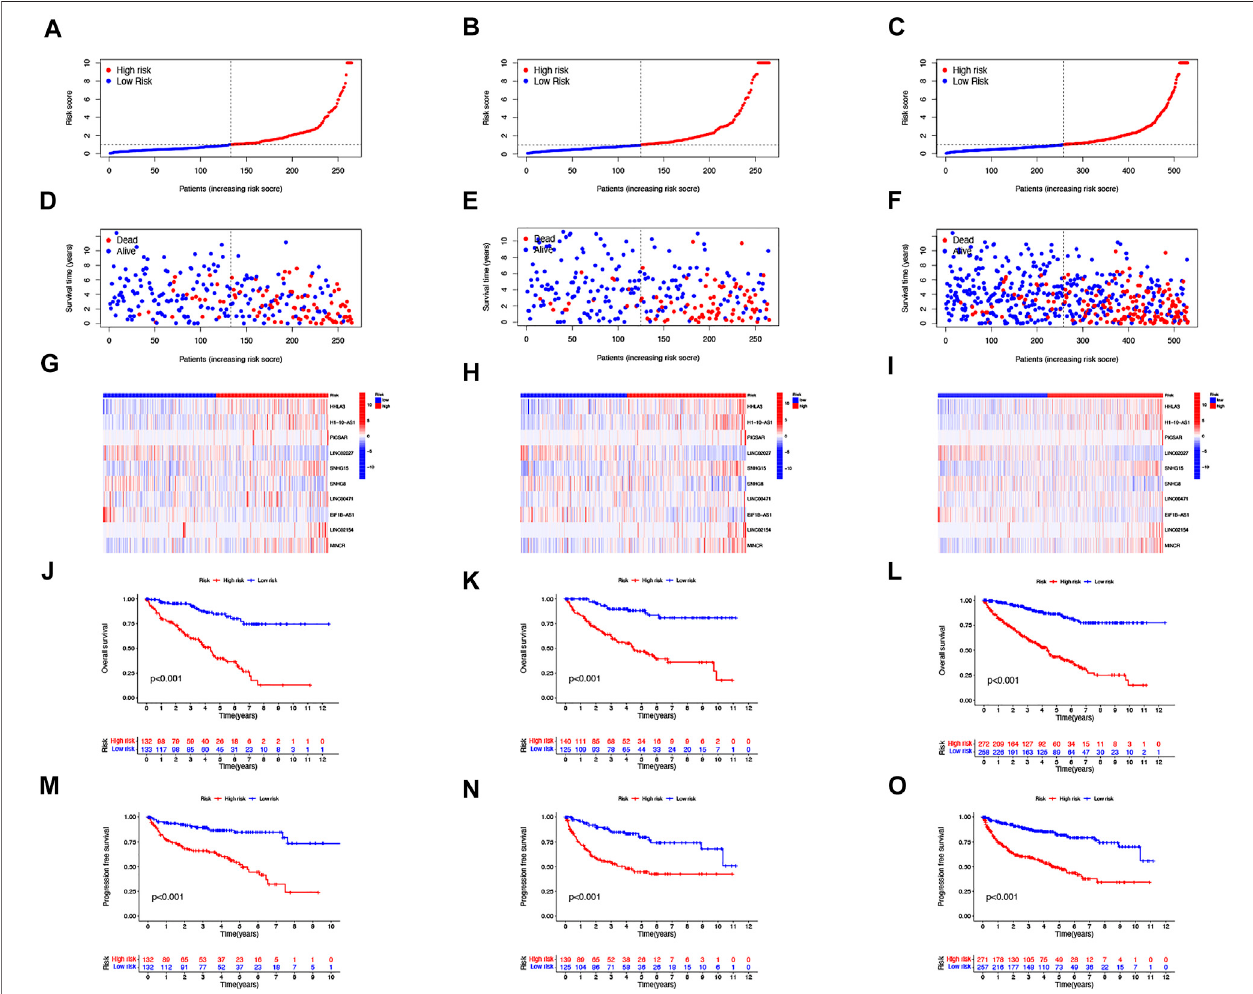
FIGURE2| Prognosisoftheriskmodelindifferentgroups.Thedistributionofoverallsurvivalriskscores (A – C) ,survivaltimeandsurvivalstatus (D – F) ,heatmapsof 10 lncRNA expressions (G – I) , Kaplan – Meier survival curves of overall survival of ccRCC patients (J – L) , and Kaplan – Meier survival curves of progression-free survival of ccRCC patients (M – O) between low- and high-risk groups in the train, test, and entire sets, respectively.